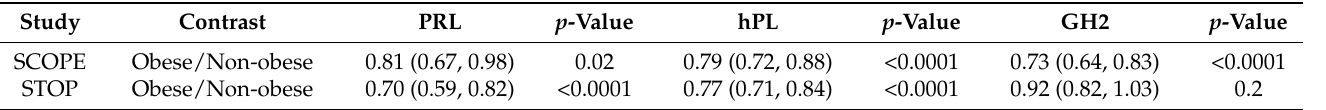
Table 6. Ratio of geometric means (95% CI) for different serum hormone concentrations in SCOPE and STOP stratified by maternal obesity